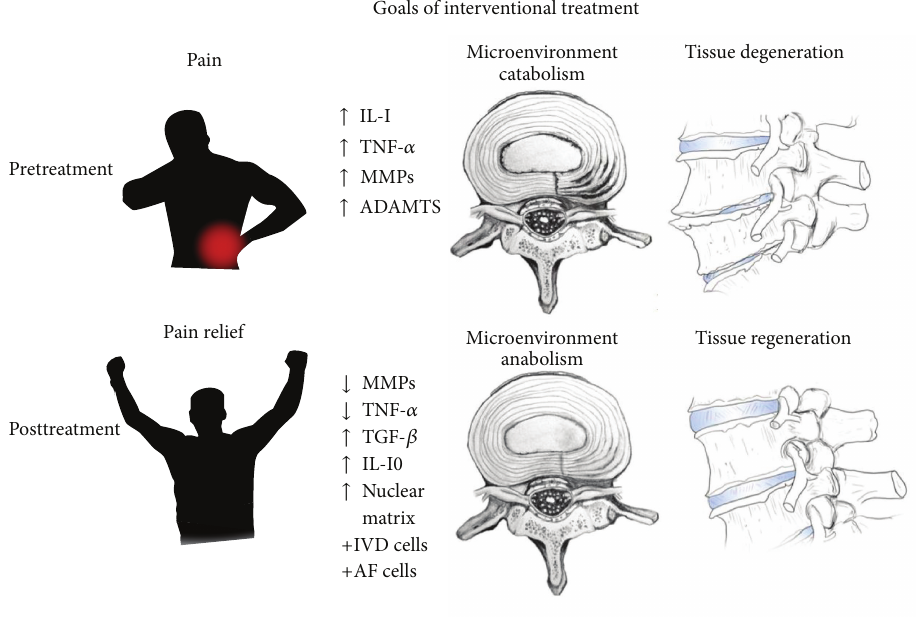
Figure 1: Goals of interventional treatment (pain relief, improved disc microenvironment, and tissue